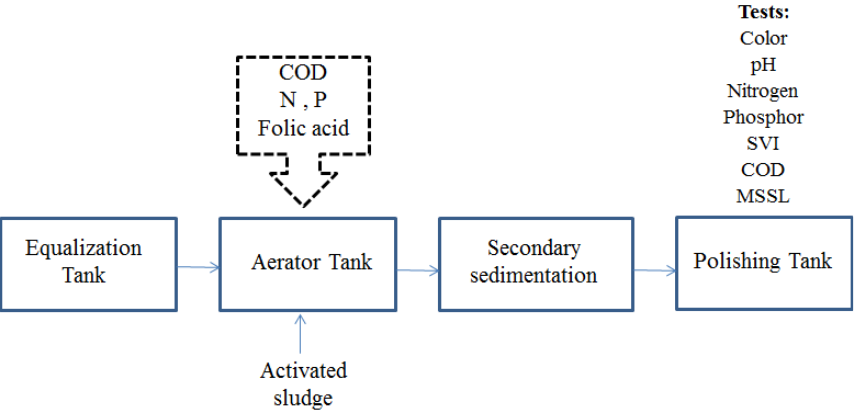
Fig. 1. A schematic diagram of wastewater treatment process in Tabriz Petrochemical Company